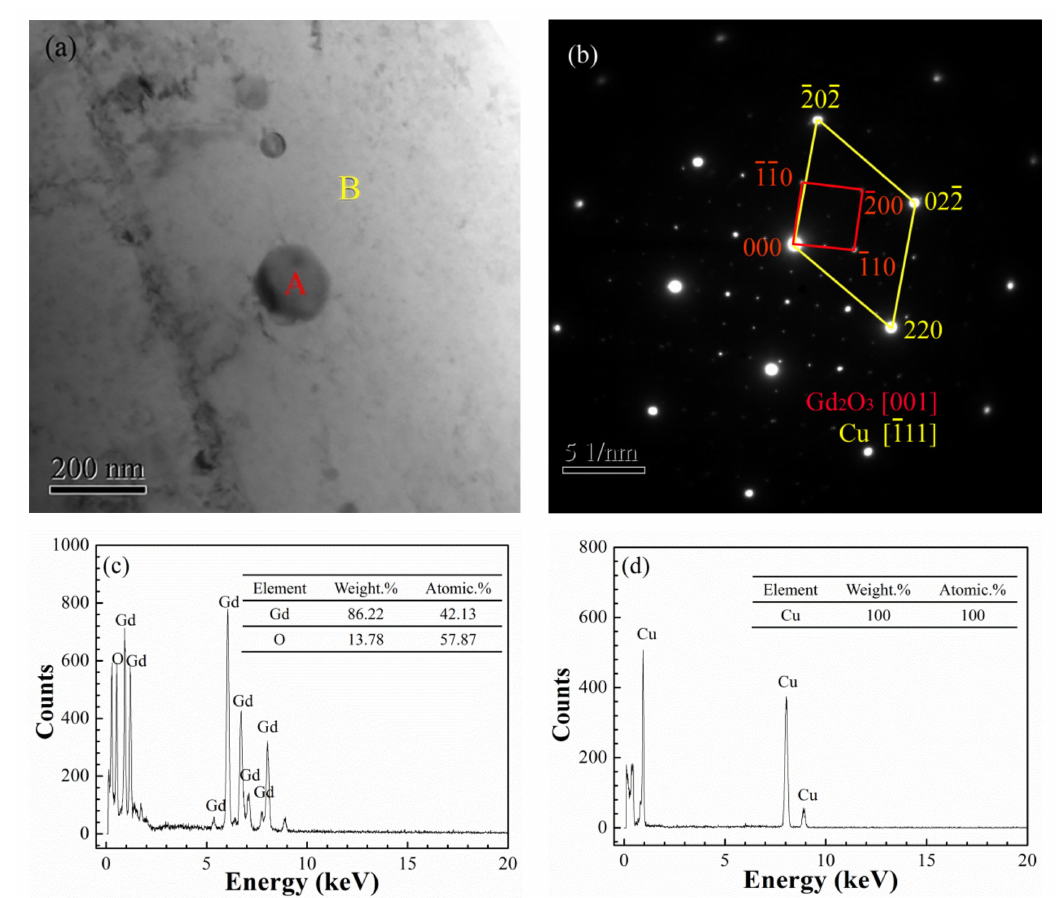
Figure 6. TEM analysis of the nano-Gd 2 O 3 /Cu composite: ( a ) morphology of the nano-Gd 2 O 3 /Cu composite, ( b ) selected area diffraction pattern, ( c , d ) corresponding EDS spectrum of the A and B points in Figure